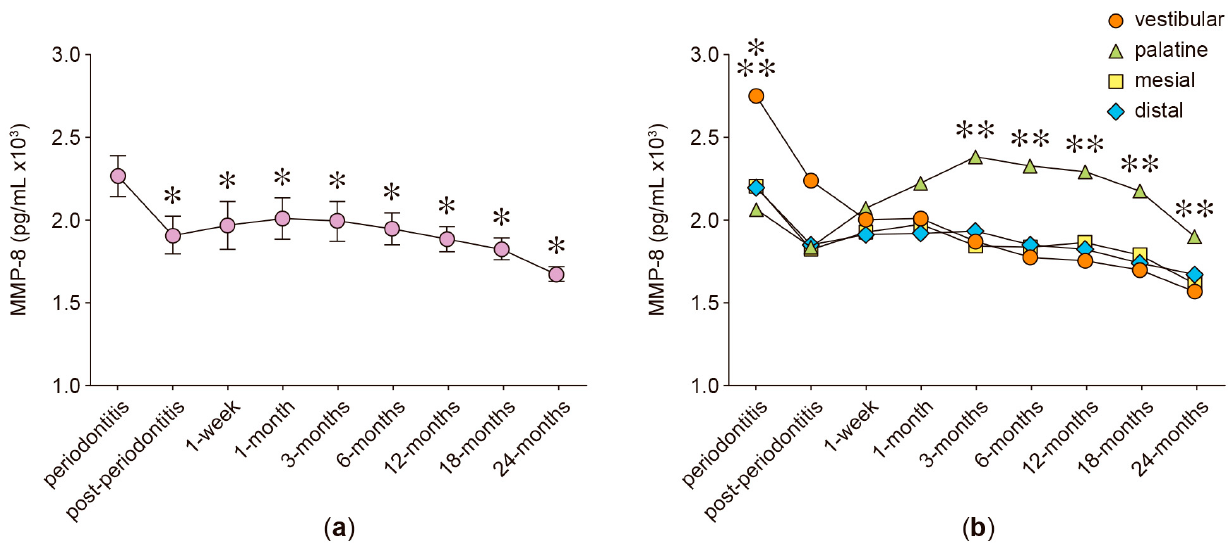
Figure 6. MMP-8 levels. ( a ) MMP-8 levels detected in the gingival crevicular fluid of